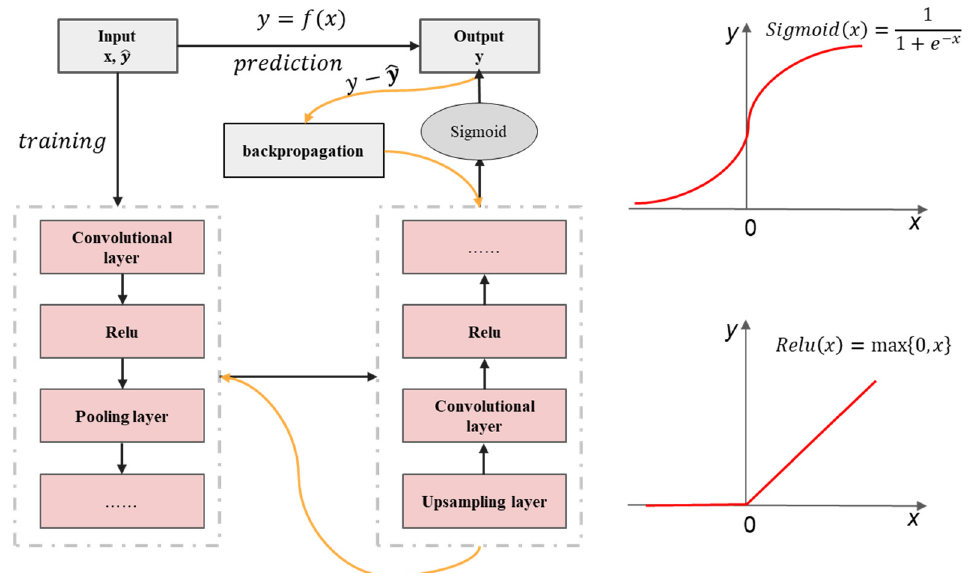
Figure 2. The Schematic diagram of the deep learning model. Relu is used to achieve non-linear transformation between the CL and PL layers.